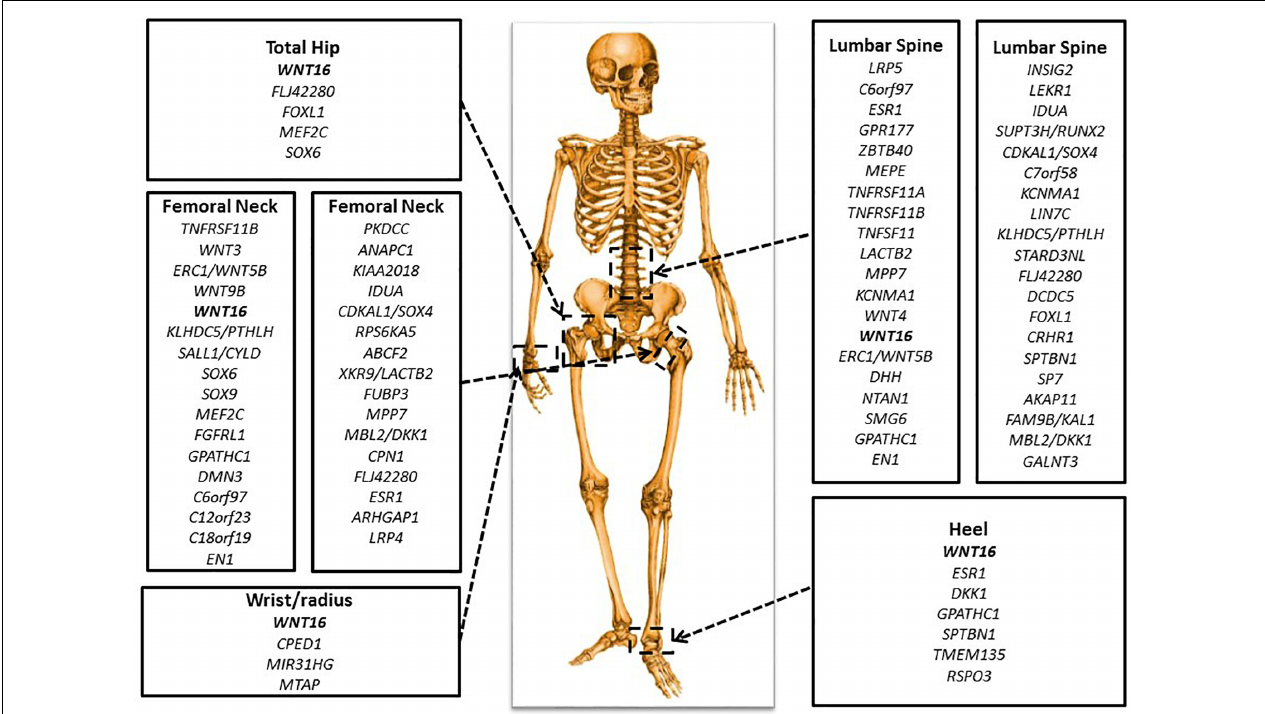
FIGURE 3 | Important genetic loci associated with BMD. There are key genes identified in GWAS for BMD at various skeletal sites: total hip, femoral neck, lumbar spine, wrist or radius, and